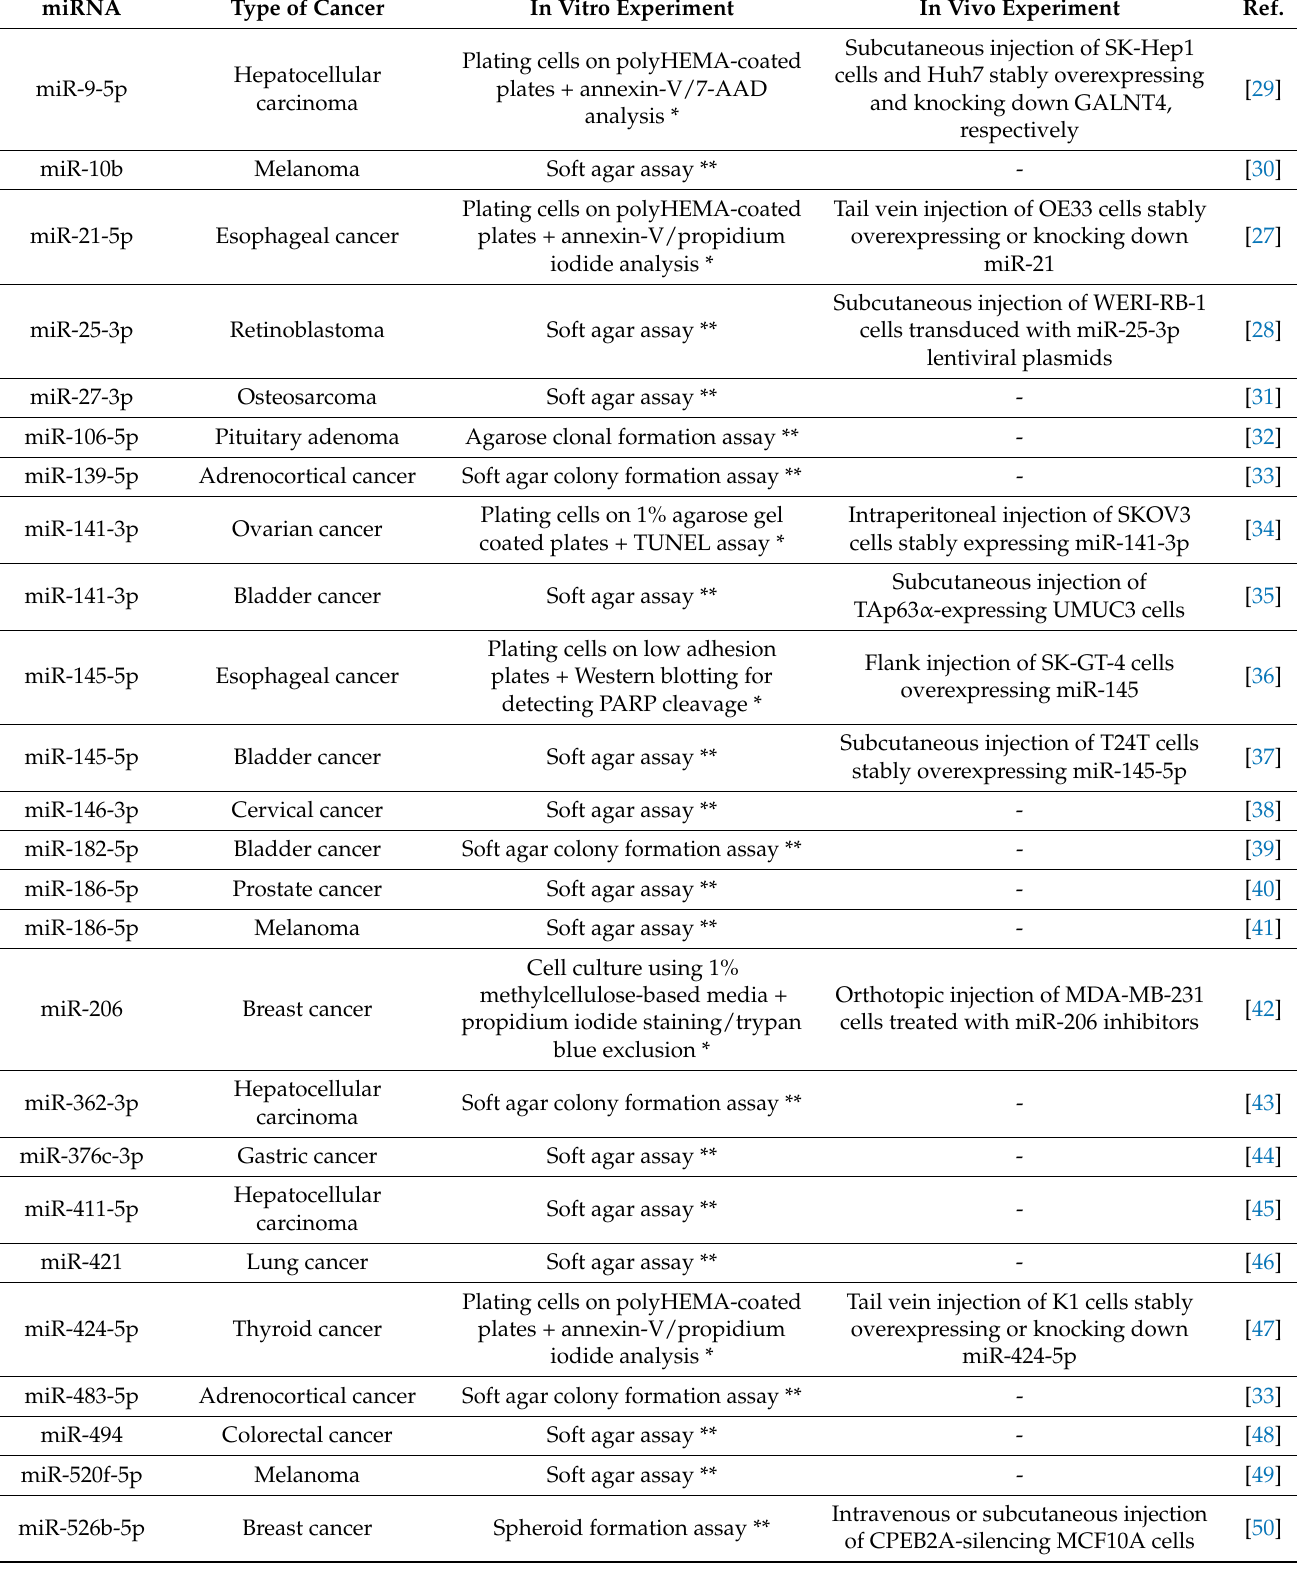
Table 1. Oncogenic miRNAs that enhance the anoikis resistance and anchorage-independent growth of cancer. miRNA